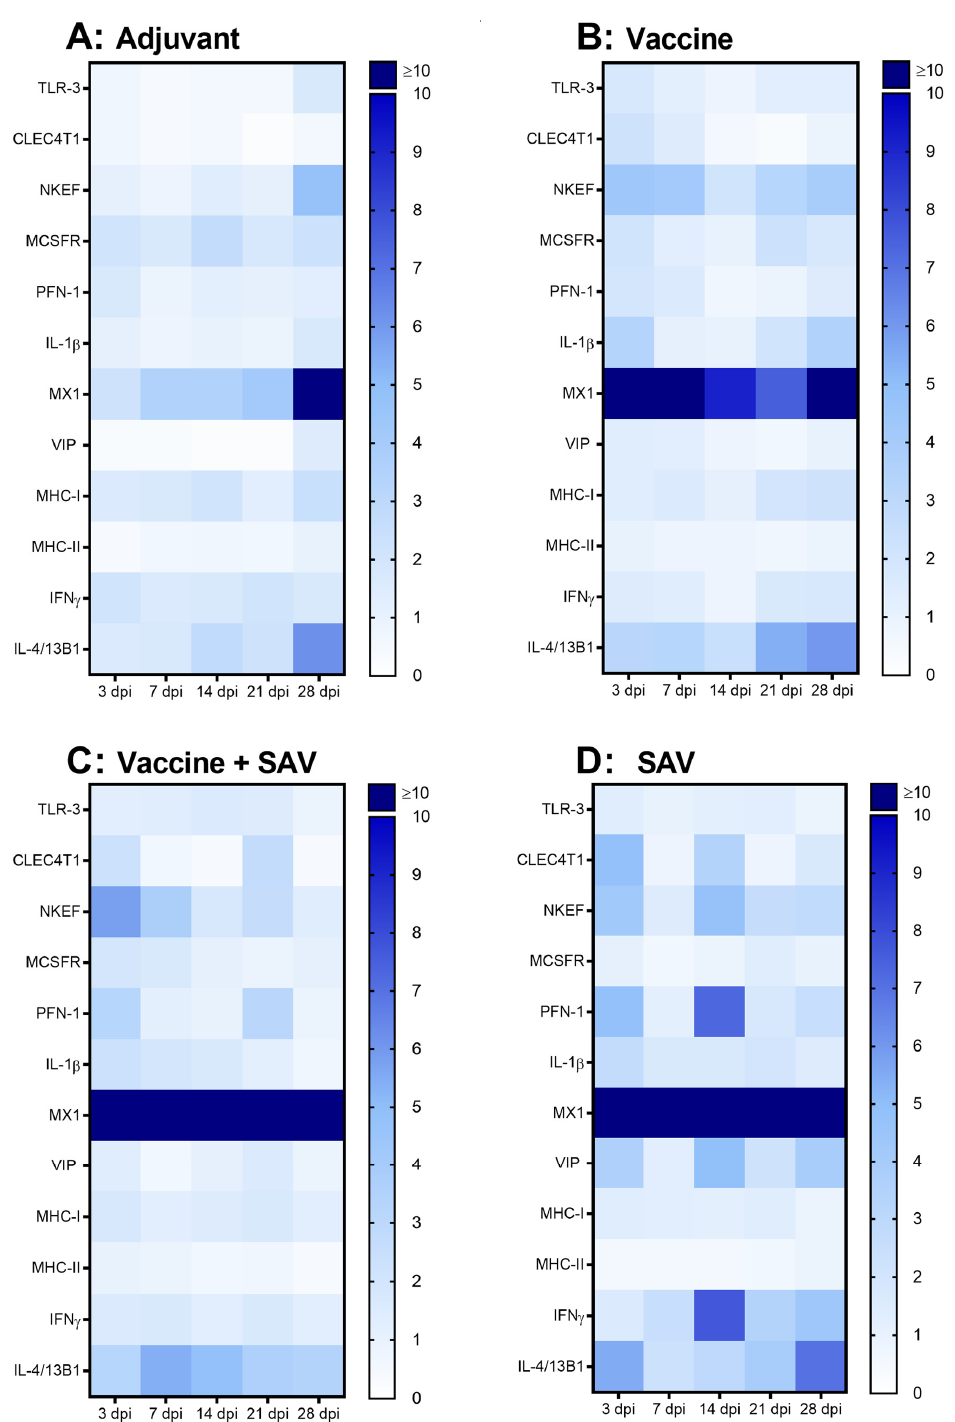
Figure 5. Heatmaps of RT-qPCR data showing gene expression (mean fold change, n = 4 / treatment group / time point) in spleen at 3, 7, 14, 21, and 28 days post injection with ( A ) adjuvant, ( B ) vaccine, ( C ) SAV challenge following vaccination, and ( D ) SAV challenge. All gene values were normalized against a housekeeping gene (EF-1 α ) followed by normalization against the average values of control group